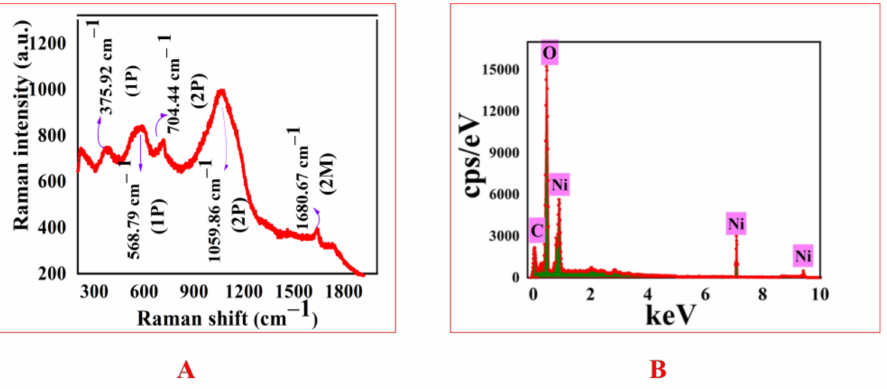
Figure 1. Spectral studies of ElA-NiONPs; ( A ) RAMAN modes; ( B ) EDX analysis.